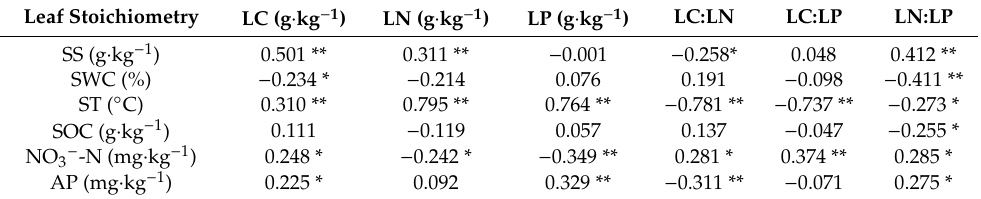
Table 4. The relationship between the dominant factors from the RDA and leaf stoichiometry of P. australis .